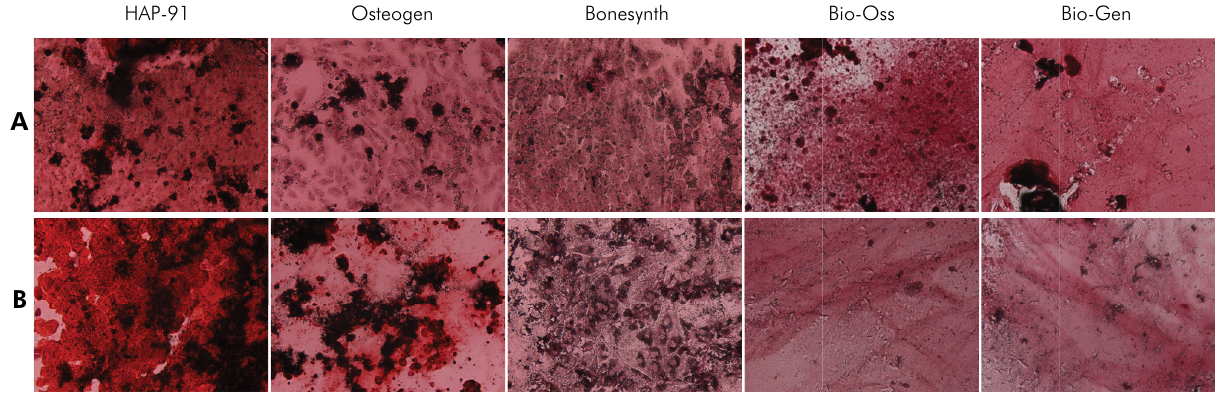
Figure 5. Representative bright-field images of alizarin red-stained MC3T3-E1 cells cultured in media conditioned with each HA under regular conditions, considering the absence (a) or addition of 0.5% v/v budesonide (b).